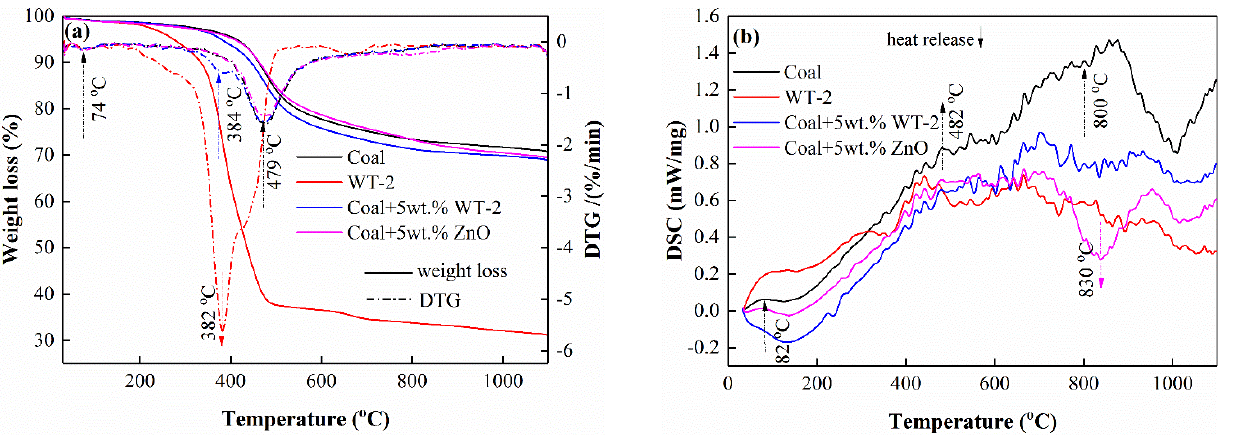
Figure 3. TG-DTG ( a ) and DSC ( b ) curves of coal, WT-2, coal containing 5 wt.% of WT-2 or 5 wt.% of ZnO.